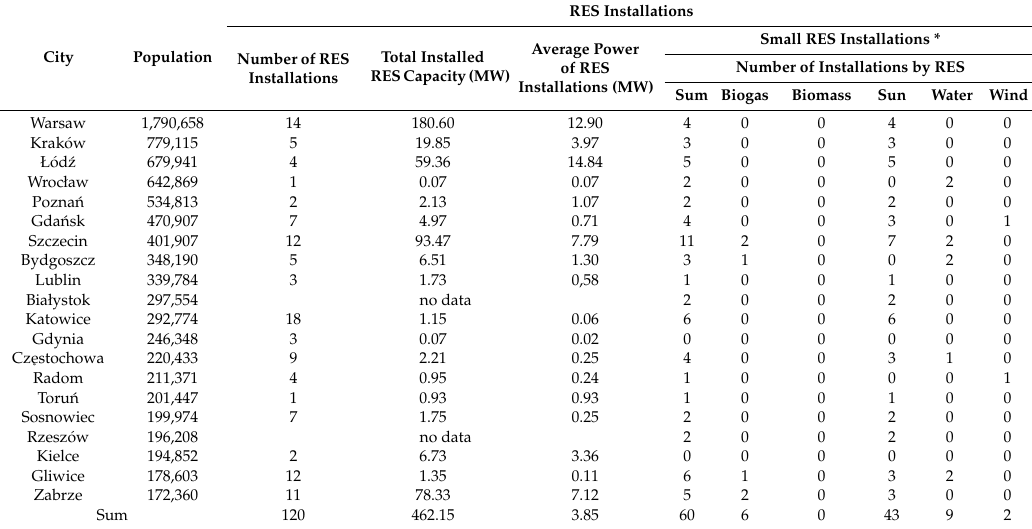
Table 2. RES installations in cities in